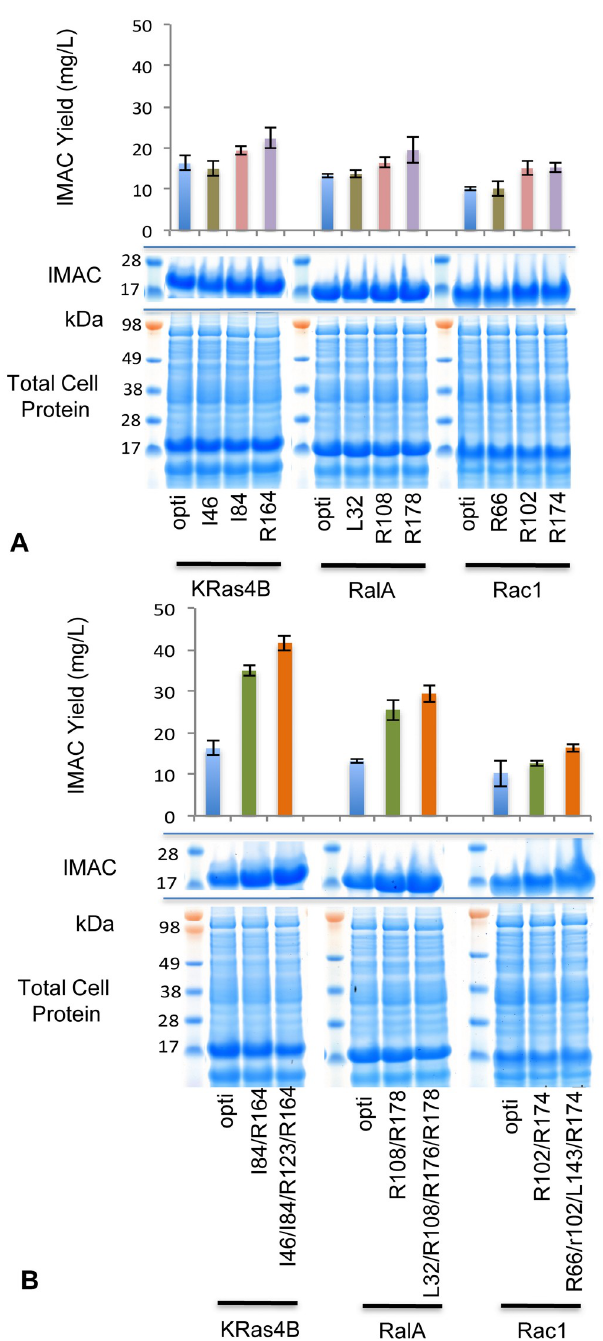
Fig 5. Introducing non-optimal synonymous codons increases soluble recovery. (A) Expression output from a series clones containing single rare codons positioned progressively through the otherwise codon optimised (opti) open reading frame. (B) Improvements in soluble fraction IMAC yield and soluble partitioning from expression constructs with either 2 or 4 rare codons imposed on the optimised open reading frame.